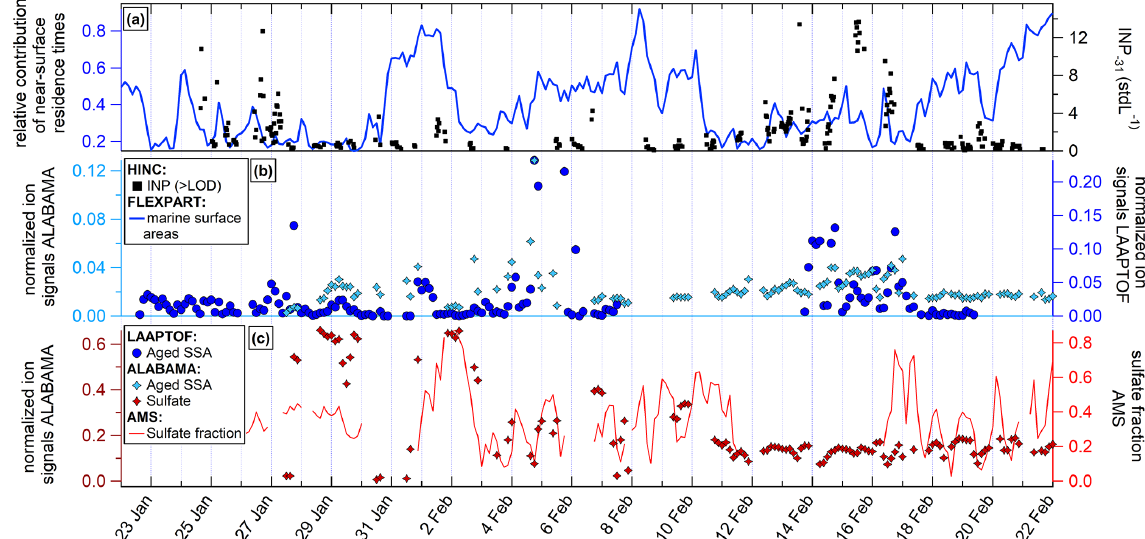
Figure 6. Time series of FLEXPART emission footprint sensitivities for marine surface areas along with INP concentration (a) ; timeline of mass spectrometer marker ions for aged sea spray aerosol (SSA) for both ALABAMA and the LAAPTOF (b) and sulfate marker ions and sulfate fraction for ALABAMA and AMS (c) . SPMS reference spectra of the aged sea spray and sulfate-containing particle types are shown in the Supplement (Figs. S9 and